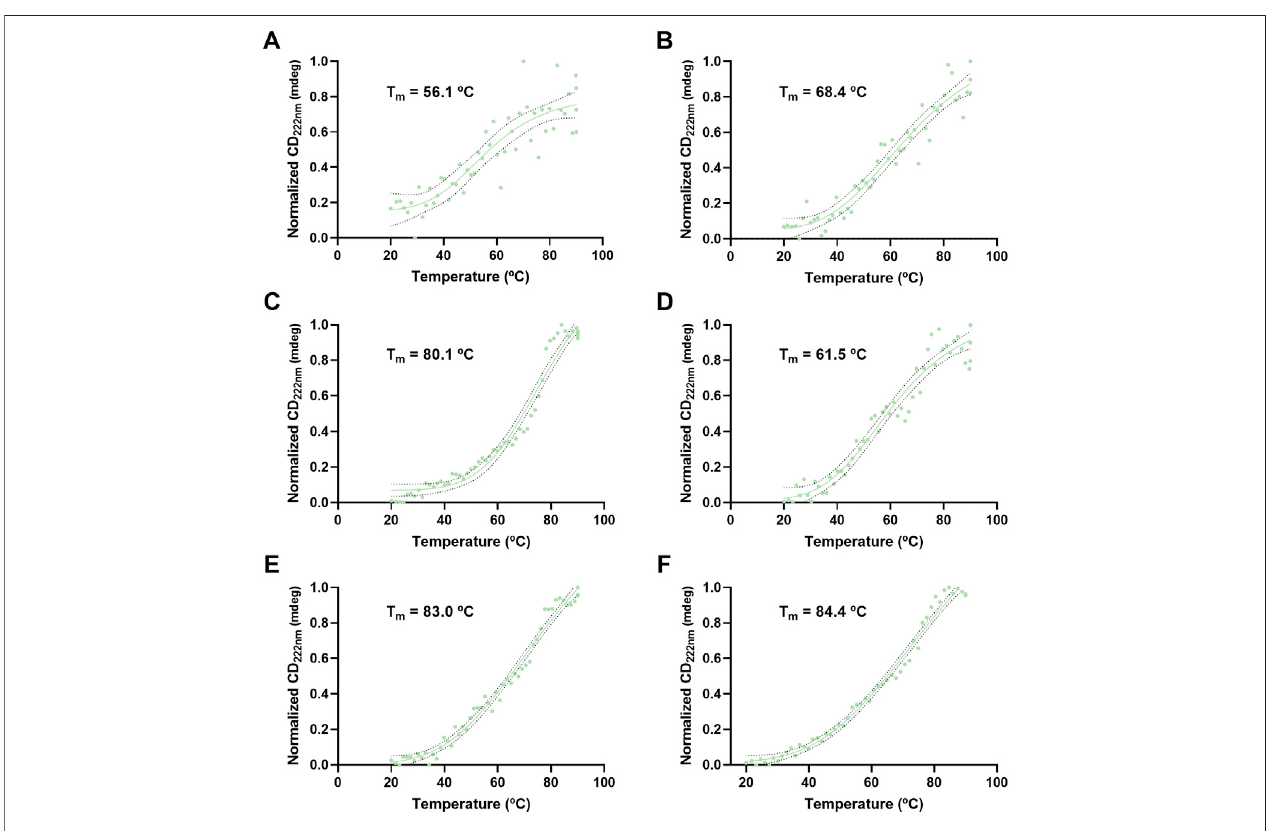
FIGURE 9 | Thermal stress analysis of in fl uenza VLPs using circular dichroism. Temperature ramp for VLP secondary structure analysis during thermal stress. CD signalwasfollowedat222 nm.Datawasnormalized(0 – 1)forplotting.mdeg:milidegrees. (A) H1MonoVLP, (B) H1PentaVLP, (C) H3MonoVLP, (D) H3PentaVLP, (E) B Mono VLP, (F) B Penta VLP. Indirect measurement of T m values was estimated by interpolation applying a sigmoidal